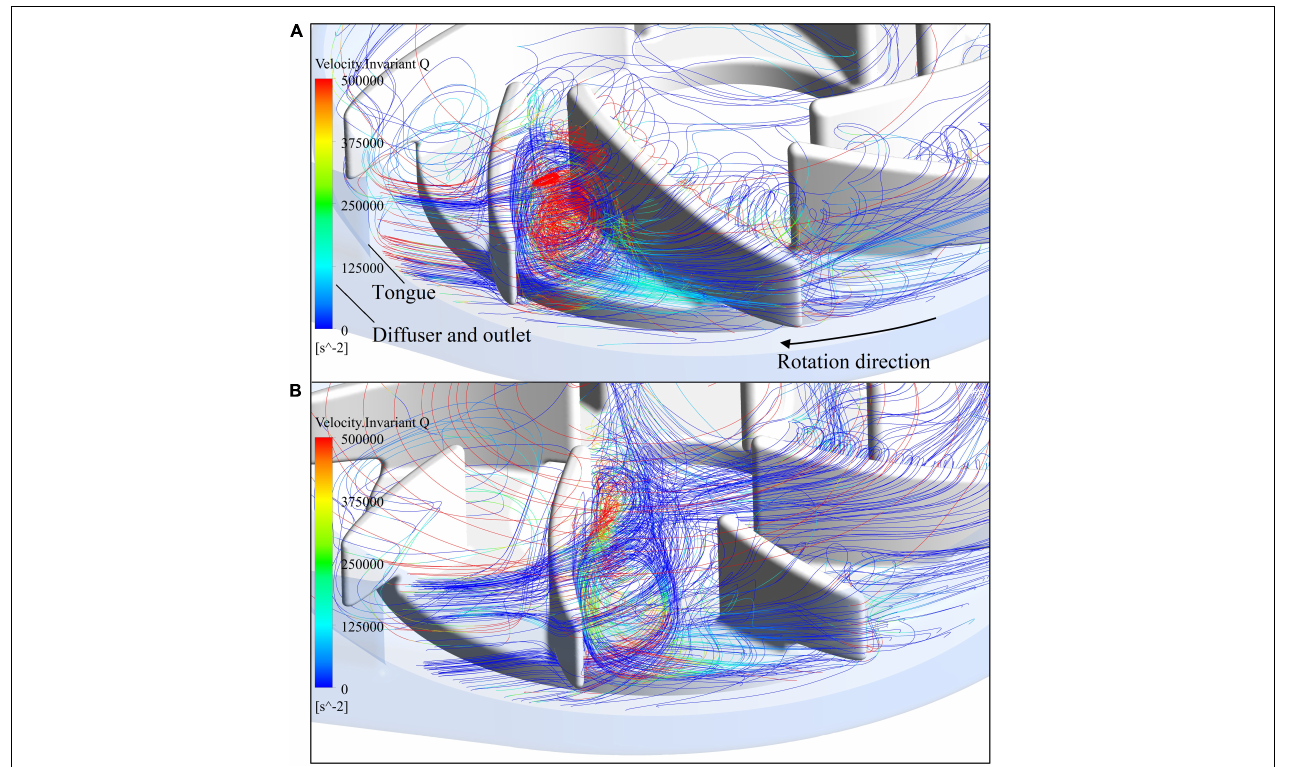
FIGURE 5 | Streamlines in the blade passage near the tongue, colored by invariant Q of velocity: (A) model 1; (B) model 2.